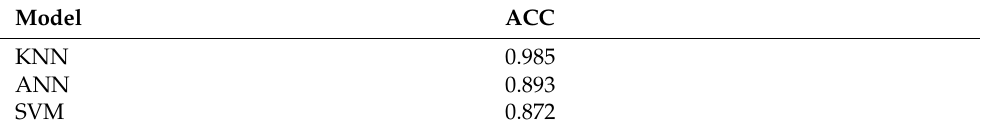
Table 15. The DR stages classification training results using machine learning.